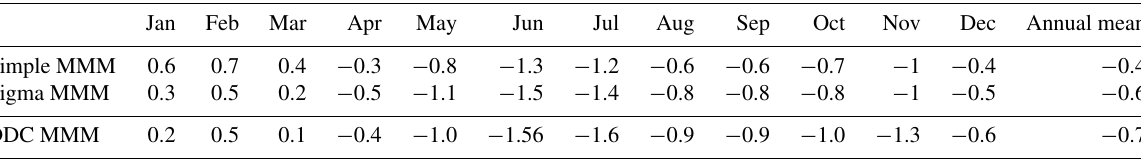
Table 2. Global monthly mean bias (DU) in tropospheric ozone column (see Eq. (1)) among the various MMMs and observations presented in Table 1.